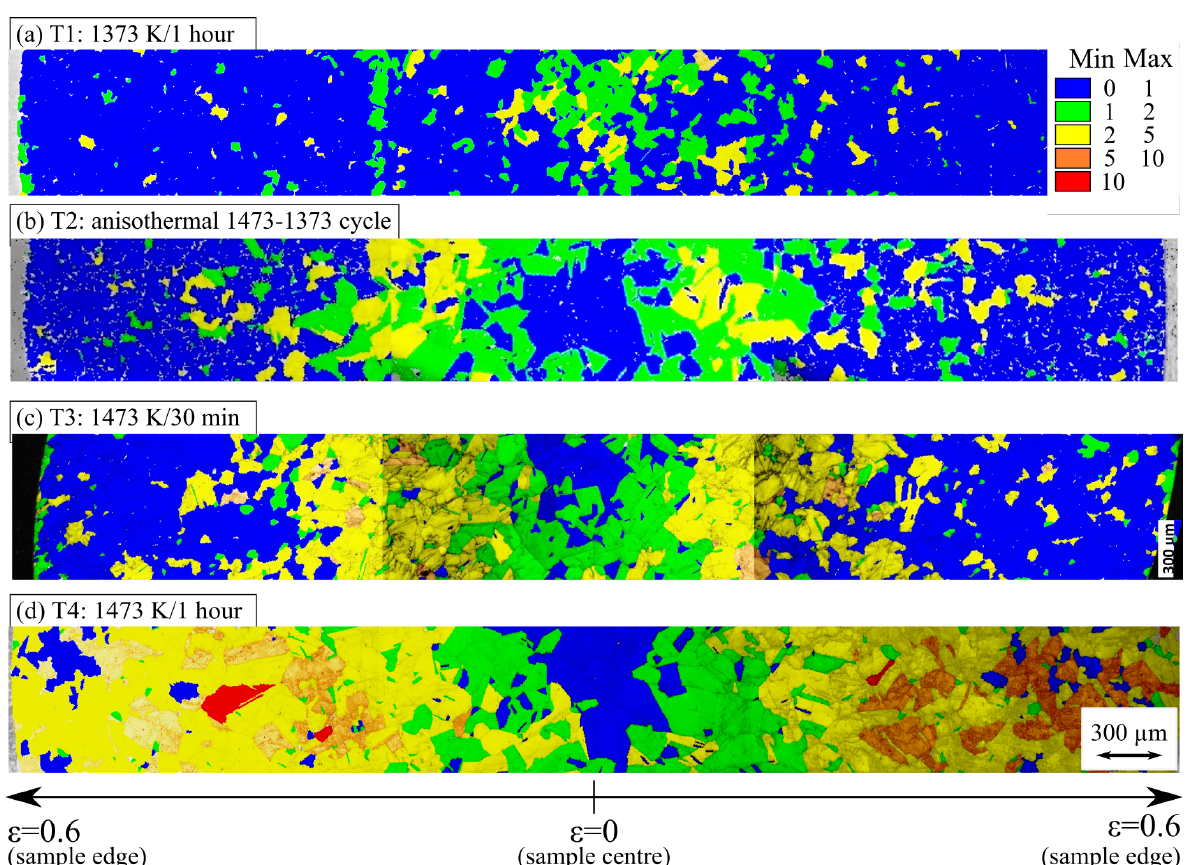
Figure 12. Grain orientation spread (GOS) and image quality of EBSD patterns over one diameter of hot torsion samples after different heat treatments prior to deformation. The specimen axis is perpendicular to the figure. Table 7. Mean Nb content in austenite after different heat treatments prior to hot torsion testing calculated using the reduced thermokinetic model (nine-element calculation using TCFE9 database) and recrystallized fractions determined using EBSD for intermediate strains of ε = 0.2 and ε = 0.4 after hot torsion testing followed by slow cooling and final annealing between 1323 and 1373